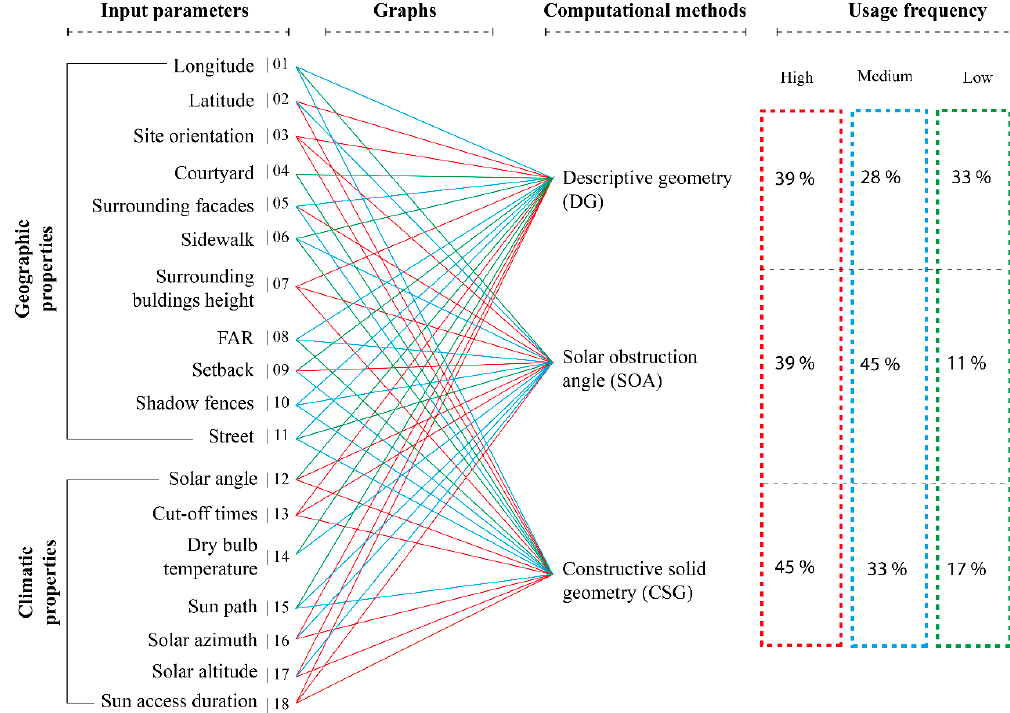
Figure 3. Categorization of design parameters and corresponding methods based on usage